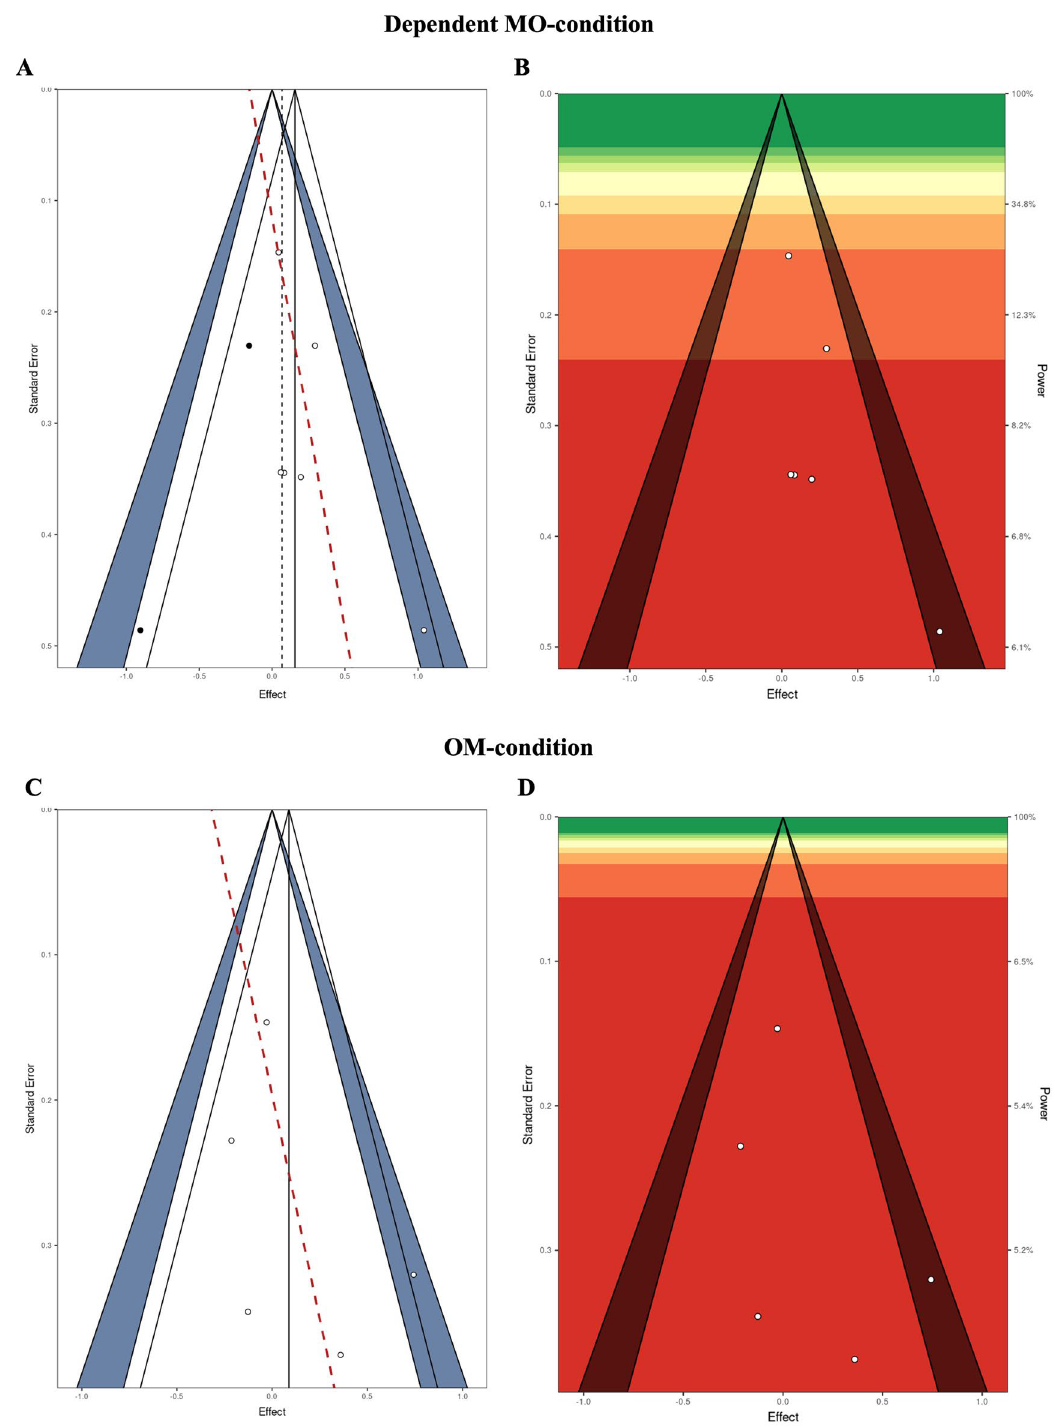
Figure 3. Contour-enhanced funnel plots with imputed trim-and-fill values as well as Egger’s regression line (Panels ( A ) and ( C ) for the dependent MO- and OM conditions) and power-enhanced funnel plots (Panels ( B ) and ( D ) for the dependent MO- and OM conditions) of published sample effect sizes. The dependent MO-condition includes studies with one-group pretest–posttest designs examining exposure to KV448 versus silence 7,12,25,26 . The OM-condition includes studies with one-group pretest–posttest designs examining exposure to other music than KV448 versus silence 12,25,26,29 . Primary study power of effect sizes in segments with cold colors is larger (dark green indicates 90–100 percent power) than those in segments with warmer colors (dark red indicates 0–10 percent power); segments represent 10 percent increments. The highest level of individual study power observed in Panel ( A ) was 15% and 6.5% in Panel ( B